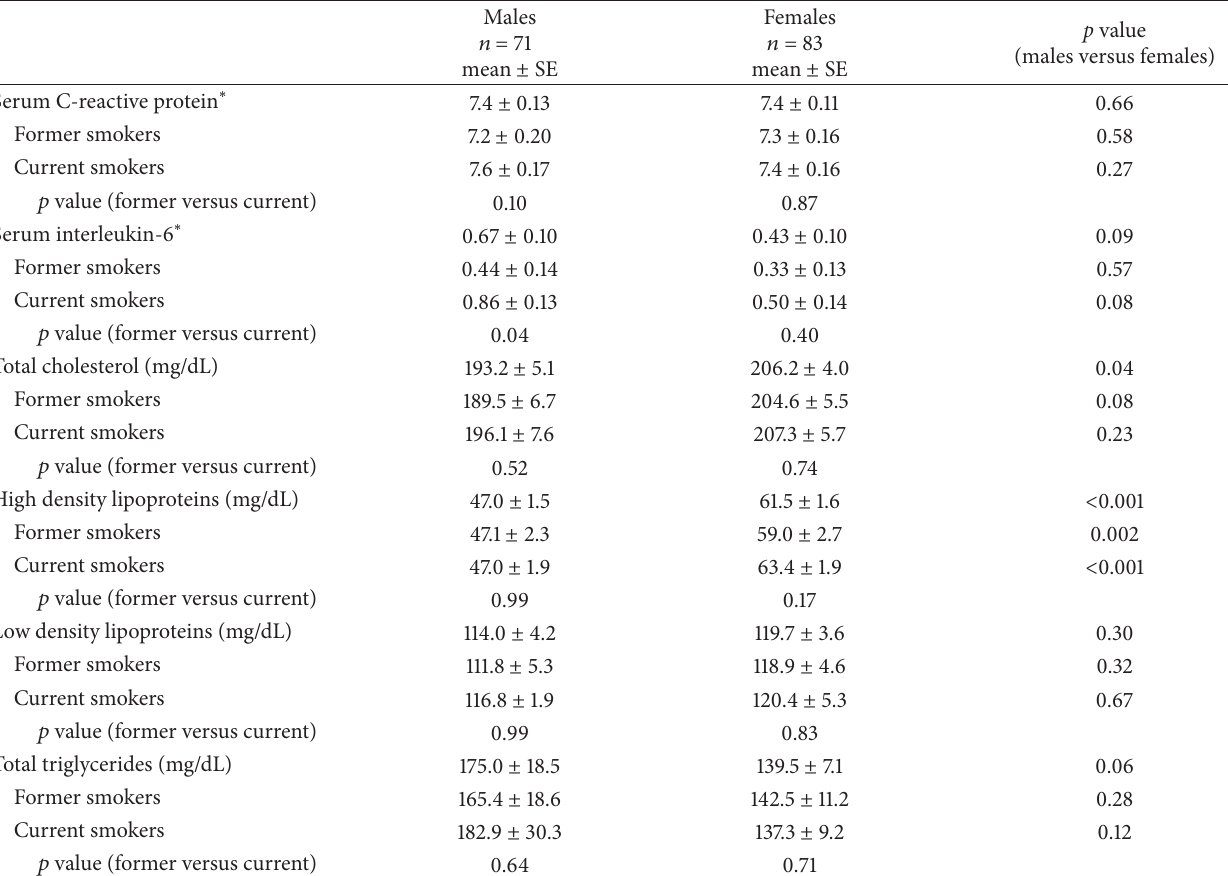
Table 2: Biomarkers of inflammation and lipid profile by gender and smoking status ( 𝑛 =